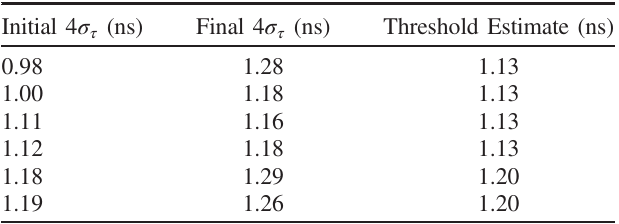
TABLE VI. Bunch length before and after instability, and corresponding threshold